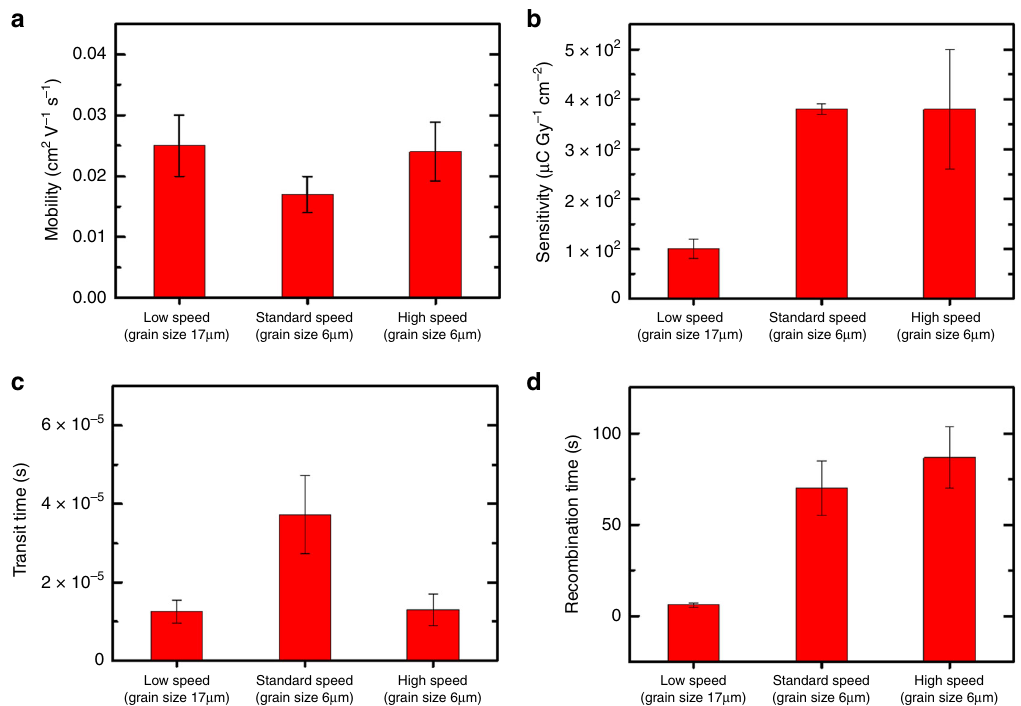
Fig. 3 Correlation between mobility, sensitivity, and traps. Experimentally determined hole mobility ( a ) and sensitivity ( b ); analytically determined transit time ( c ) and recombination time ( d ) for pure TIPS-pentacene-based samples deposited at different speeds (i.e., with different grain sizes). The error bars refer to the statistical fl uctuations of the parameters over four samples for each deposition